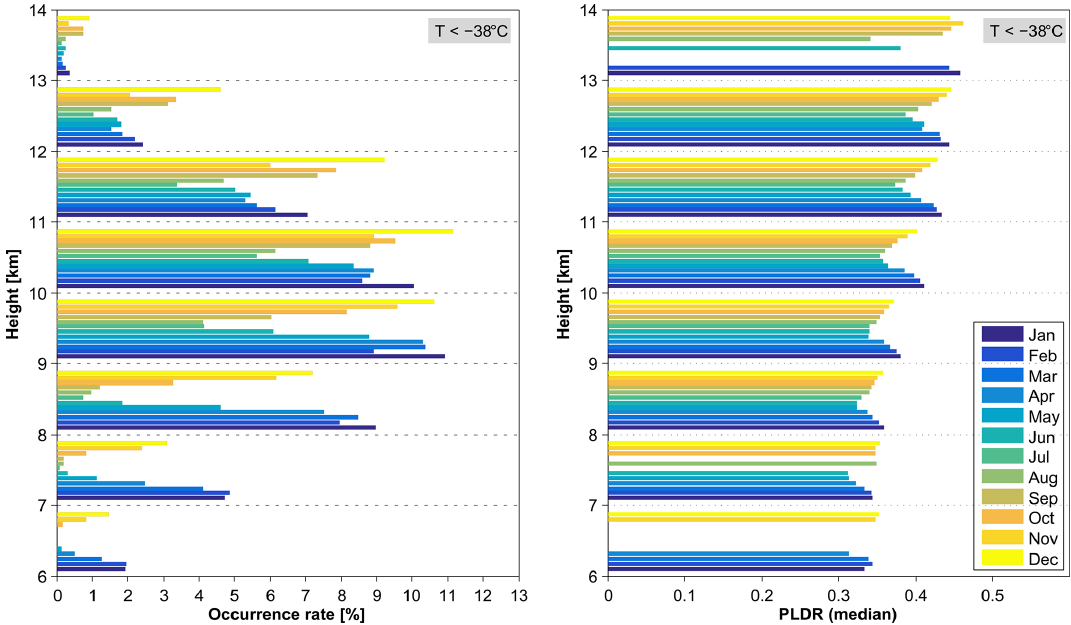
Figure 4. Distributions of the occurrence rate (OR) and PLDR of cirrus clouds in each 1km altitude bin. Both parameters follow a seasonal cycle: cirrus clouds in winter are characterized by larger values of PLDR and higher ORs than in summer. Furthermore, cirrus clouds appear within the full altitude range from 6 to 13km in the winter months but only within the altitudes from ∼ 9 to 12.5km in summer.